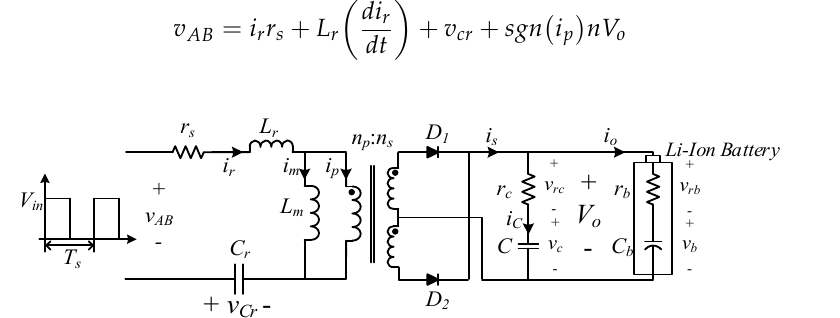
Figure 4. Equivalent circuit of the LLC resonant converter.